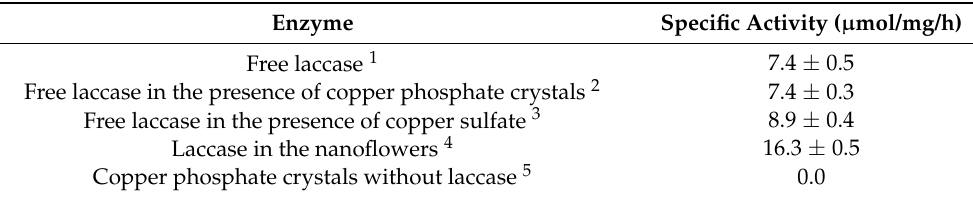
Table 1. Comparison of specific activity of free and immobilized laccase in different